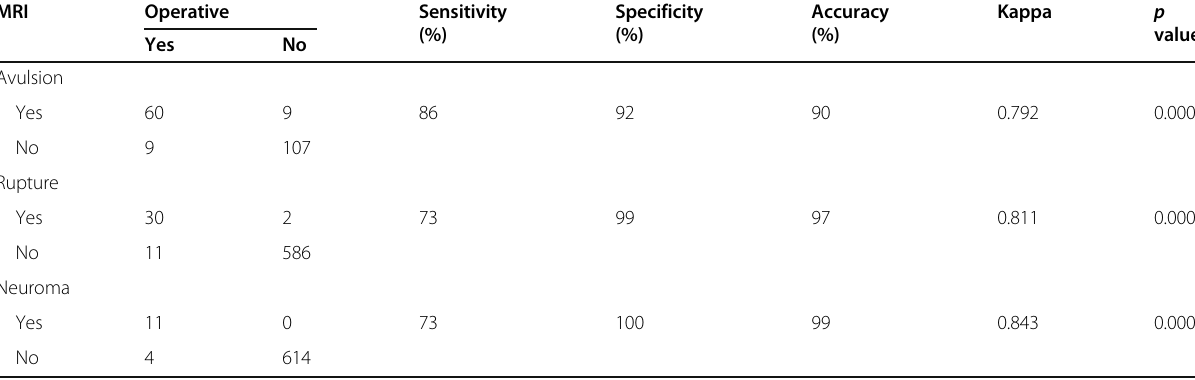
Table 1 MRI diagnostic results in detection of preganglionic and postganglionic injury in all cases including adult and obstetric cases compared to operative